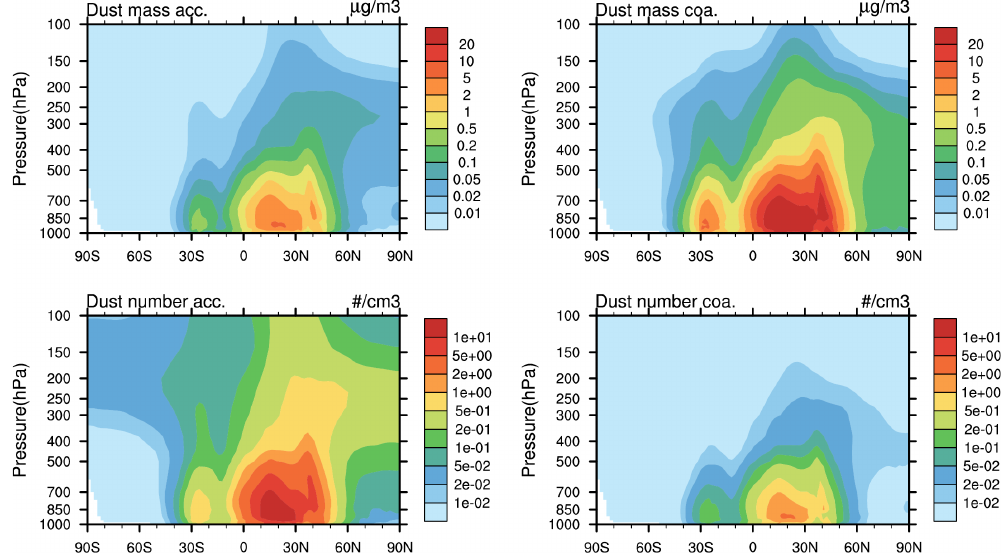
Fig. 1. Annual mean and vertical cross sections of mass (upper) and number (lower) concentrations of mineral dust in the accumulation Figure 1. Annual mean and vertical cross sections of mass (upper) and number (lower) mode (0.1–1µm diameter, left) and in the coarse mode (1–10µm diameter, right). Results are taken from the LP05 combined simulation and concentrations of mineral dust in the accumulation mode (0.1-1 µ m diameter, left) and in represent 5-yr averages. the coarse mode (1-10 µ m diameter, right). Results are taken from the LP05 combined simulation and represent 5-year averages.